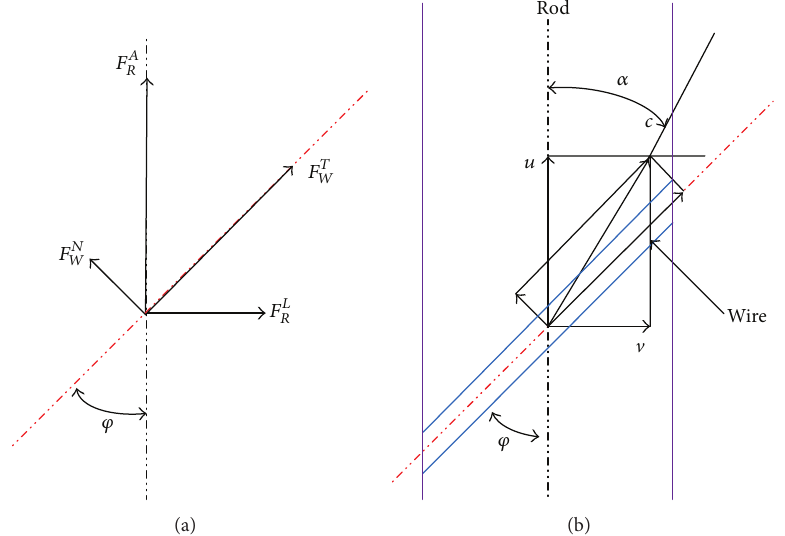
Figure 2: Component of the drag forces and velocities in a wire wrapped rod.